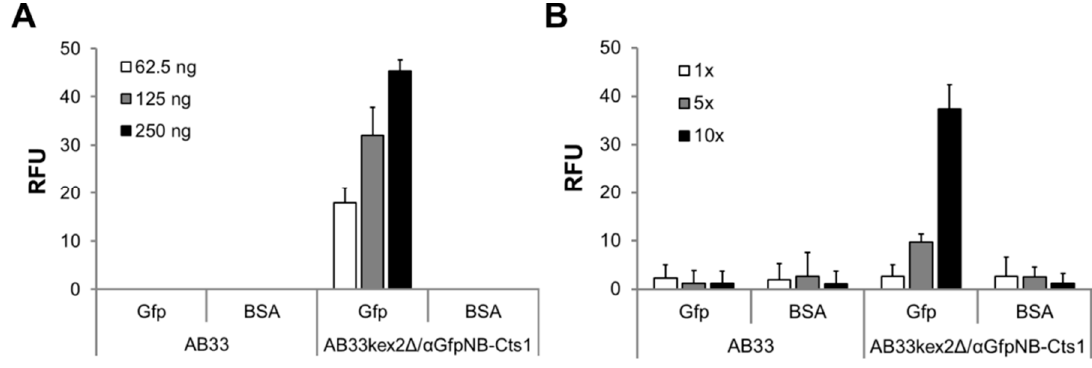
Figure 2. Biochemical characterization of the α Gfp nanobody. ( A ) Detection of purified His-tagged green fluorescent protein (Gfp H ) in enzyme-linked immunosorbent assays (ELISA) using 10 μ g of whole cell extracts of strain AB33 (no nanobody) and the Kex2-deficient nanobody expression strain AB33kex2 Δ / α GfpNB-Cts1; ( B ) Detection of purified Gfp H in ELISA assays using distinct volumes of immobilized metal affinity chromatography (IMAC)-purified fractions obtained from supernatants of strains AB33 (no nanobody) and AB33kex2 Δ / α GfpNB-Cts1. ELISA were performed in biological triplicates. BSA, bovine serum albumin; RFU, relative fluorescence units.